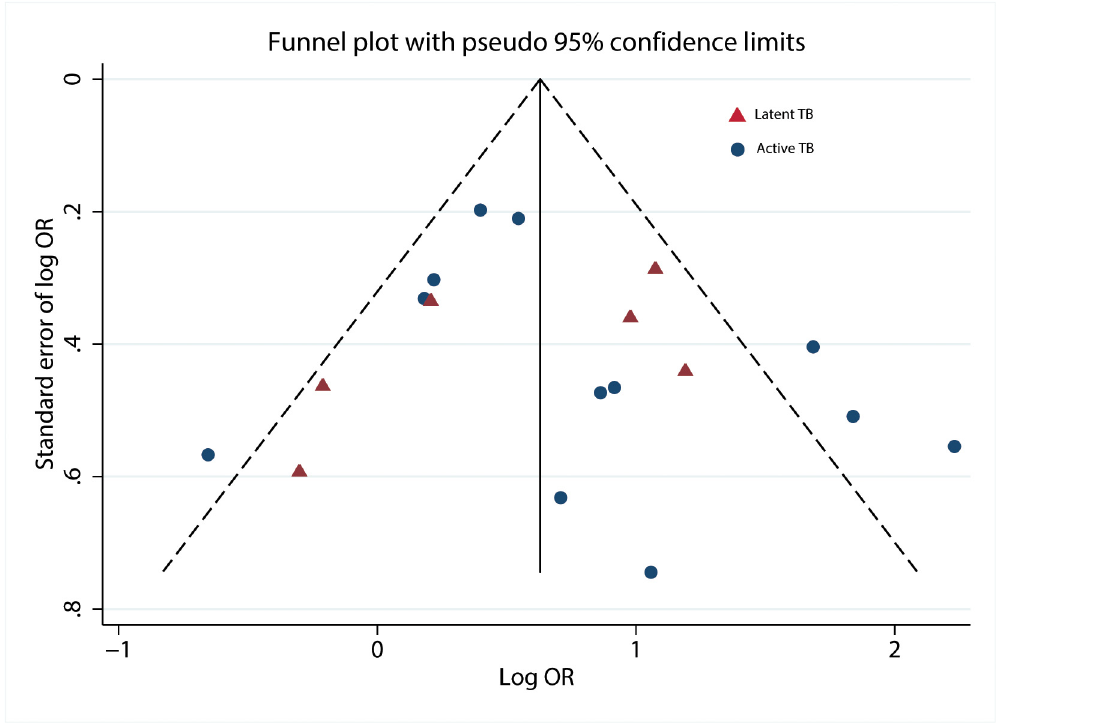
Fig 4. Funnel plot with pseudo 95% confidence limits. OR, odds